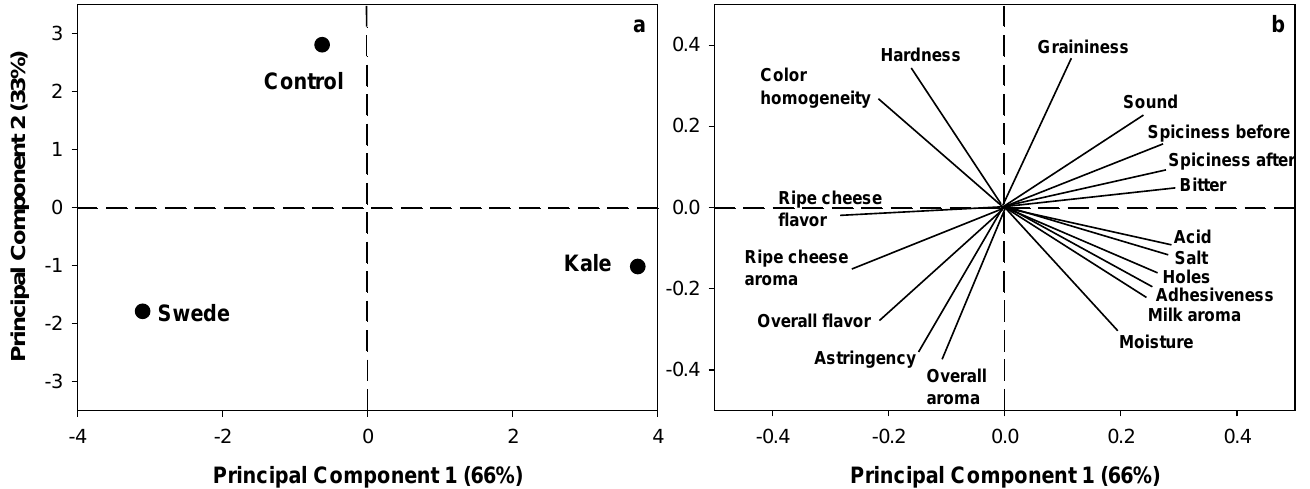
Figure 1. Score ( a ) and loading ( b ) plots obtained by principal component analyses (PCA) for all 18 sensory attributes of Chanco-style cheeses made with milks obtained from dairy cows fed with control diets or supplemented with swede or kale.